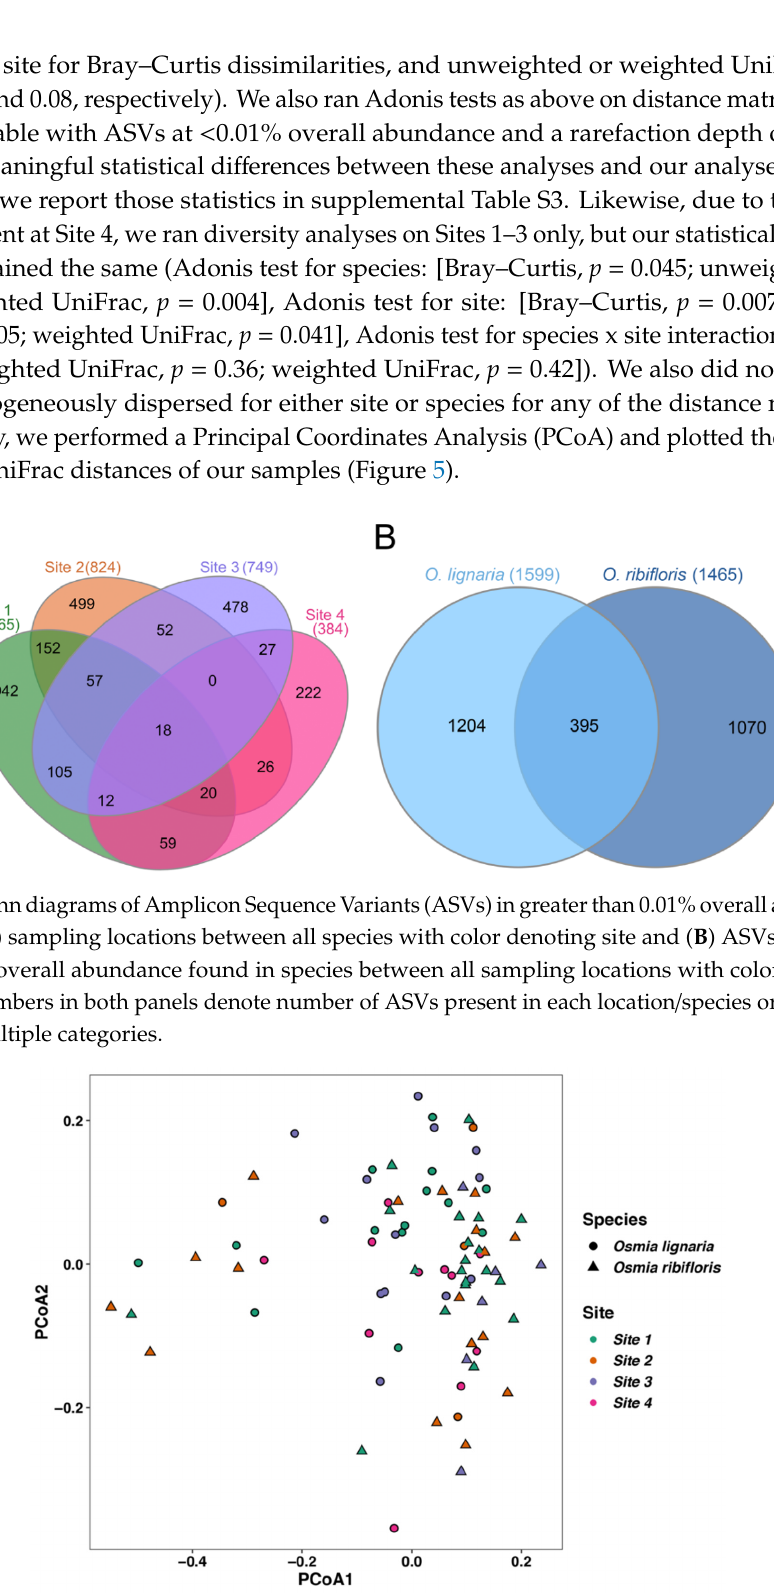
Figure 3. “Heat trees” indicating the hierarchical phylogenetic relationships and relative abundances of taxa within ( A ) O. lignaria and ( B ) O. ribifloris . Branch color denotes relative abundance of the taxonomic rank within all samples from within each species, and taxon labels represent the 75 most proportionally abundant taxa.